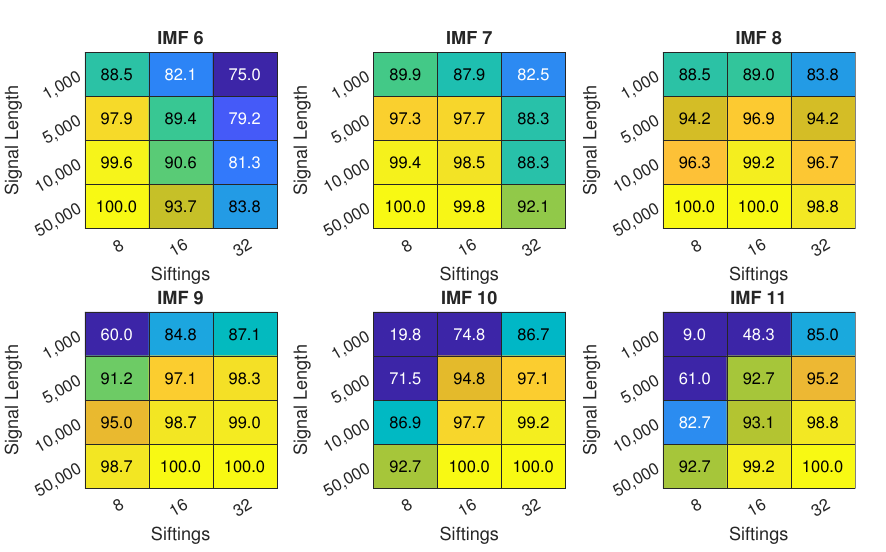
Figure 6. Inlet recirculation detection accuracy for IMFs 6 to 11 with different signal length N and different sifting iterations number; colorscale is used only for values above 75% for easier